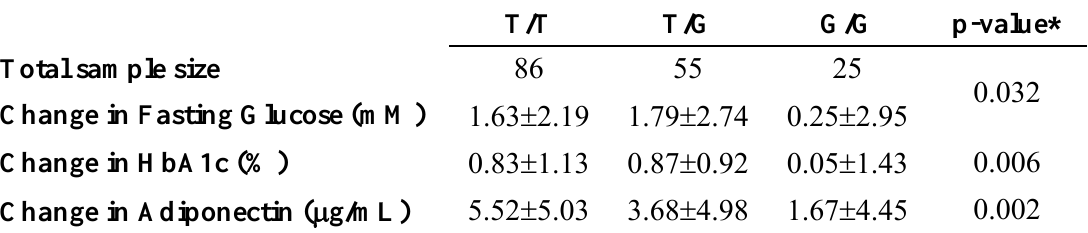
Table 1. Selected association results between rs2241766 in ADIPOQ and response to rosiglitazone therapy extracted from Table 4 from